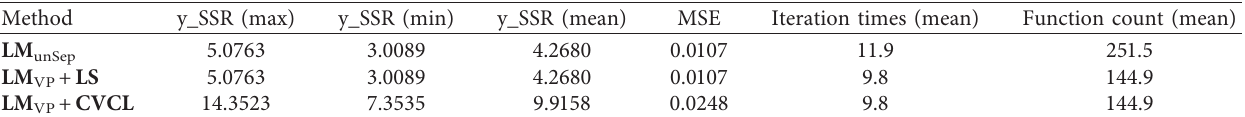
Table 3: Sum of the squared residuals between predicted values obtained using the three methods and the true observations in Example 1. Method